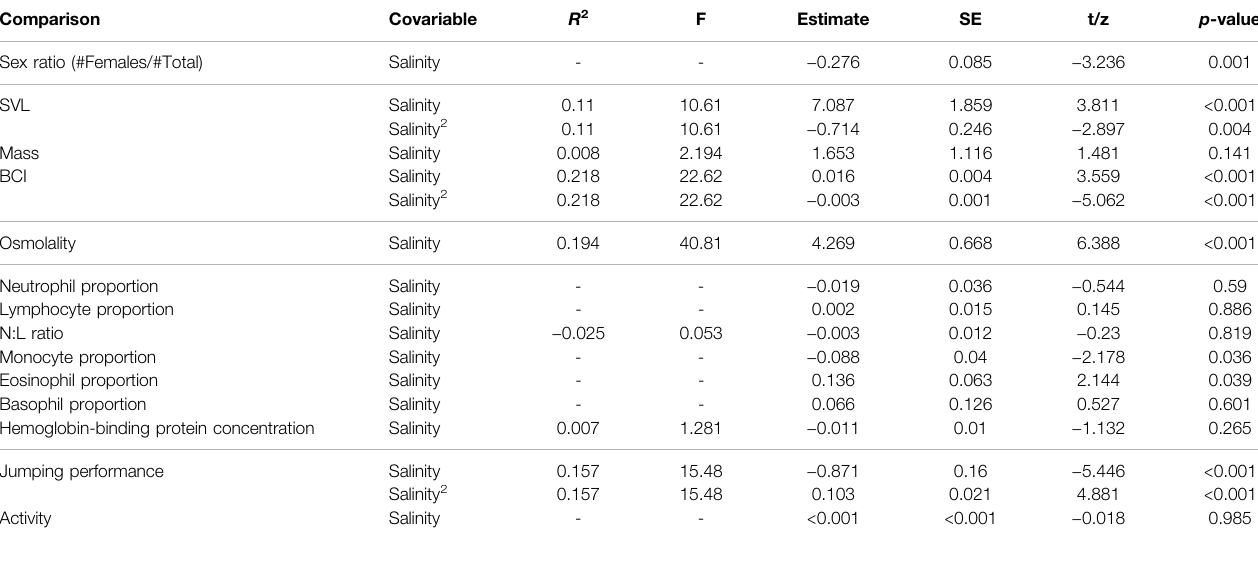
TABLE 1 | Effect of pond salinity on osmolality, SVL (size, mm), mass (g), body condition (BCI), Sex ratio, hemoglobin-binding protein, Neutrophils/Lymphocytes ratio (N:L ratio), leucocytes counts, jumping distance (as the jumping distance corrected by individuals SVL), and activity. Computed on N = 156 individuals (see also SupplementaryAppendixB fornumberofindividualscapturedoneachsite),exceptforhemoglobin-bindingproteinsandleucocytescounts,whereitwascomputedonN = 40